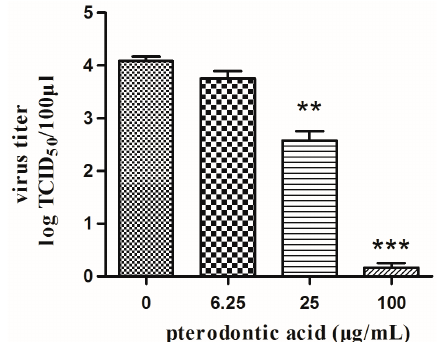
Figure 3. Assay of antiviral activity of pterodontic acid by progeny virus reduction assay. MDCK cells infected with 100 TCID 50 A/PR/8/34 (H1N1) in the absence or presence of pterodontic acid and supernatants was collected at 24 h post-infection. The progeny viruses from MDCK cells supernatants were determined by CPE assay in MDCK cells. Data were expressed as mean ± SD from three separate experiments. Data were obtained from three separate experiments. ** p < 0.01; *** p < 0.001; compared with influenza virus-infected alone.